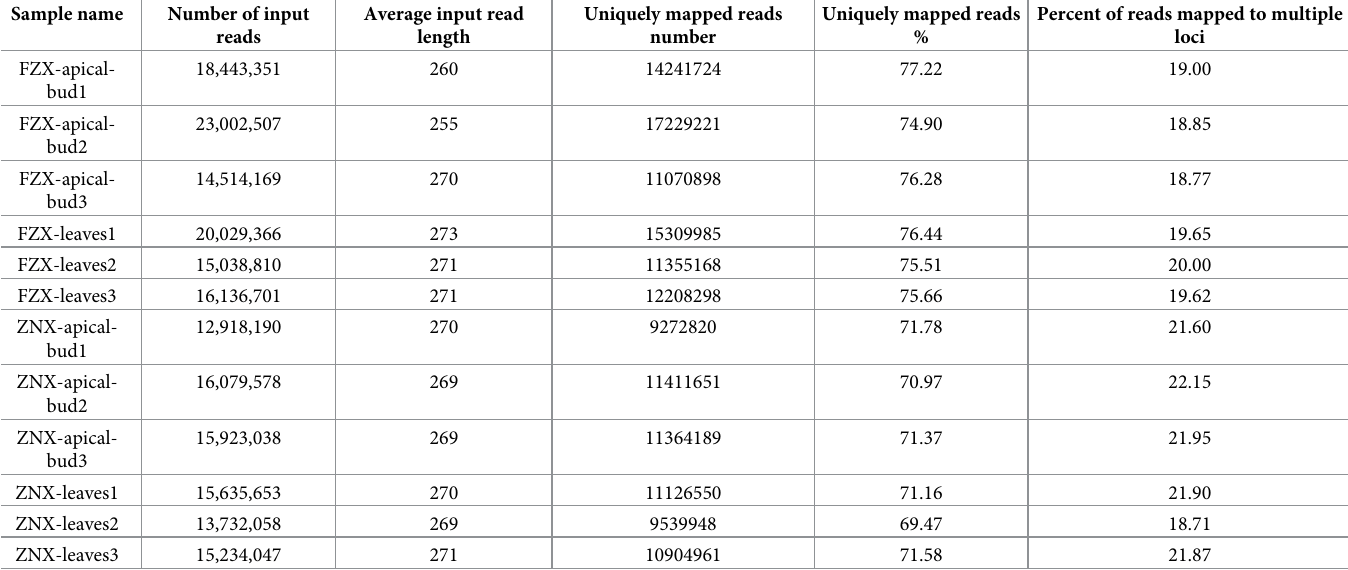
Table 2. RNA-seq reads in twelve RNA-seq libraries.